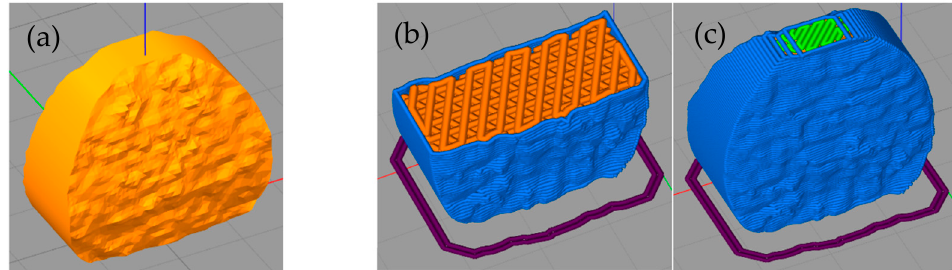
Figure 4. Pre-processing of 3D printing and output in the form of an intervertebral disc implant made of PLA/PHB + HA/TCP material. ( a ) Intervertebral disc model; ( b ) Simulation progress—detail on he filling of the model; ( c ) Final stage of